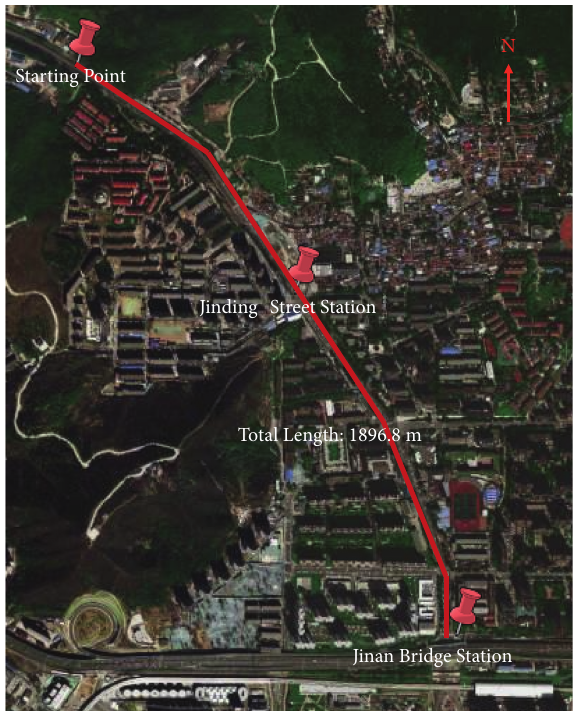
Figure 3: Project layout of the Winter Olympic branch line of Beijing Metro Line